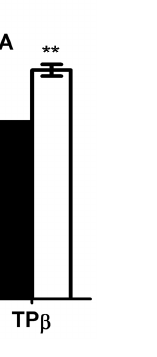
Figure 6. DP1 does not undergo constitutive internalization. Cell surface receptor expression was measured by ELISA as described under ‘‘Materials and Methods’’ in HEK293 transiently co-transfected with pcDNA3-Flag-DP1 or pcDNA3-Flag-TP b in combination with pcDNA3 or pcDNA3-dynamin-K44A, a dominant negative mutant of dynamin. Data are shown as the percentage of cell surface receptor expression in cells co-transfected with pcDNA3 for each receptor. Results are the mean 6 S.E. of at least three independent experiments. ** is P , 0.01.